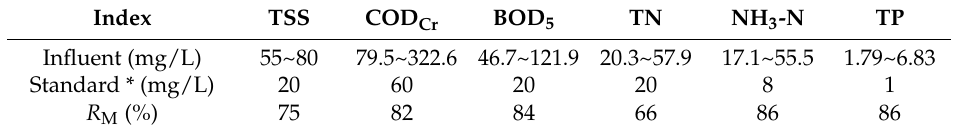
Table 2. Pollutant concentration in the influent and designed standard of the